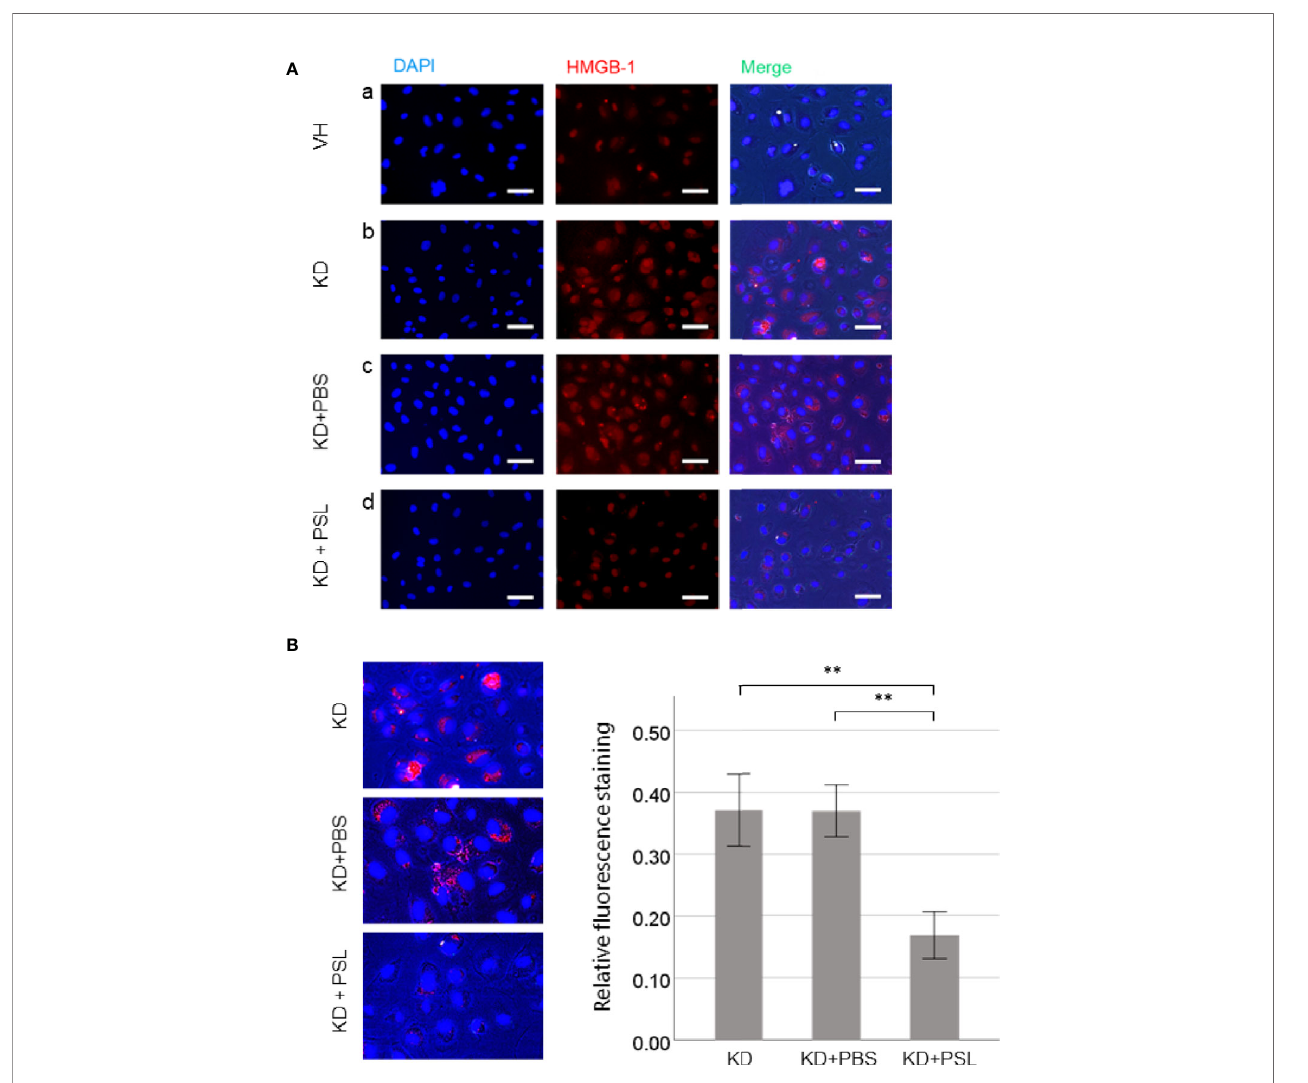
FIGURE 3 | Immunostaining of HMGB-1 in serum-activated human coronary artery endothelial cells (HCAECs) (magni fi cation, ×400). (A) Representative images of from healthy control (VH), Kawasaki disease (KD), and KD serum-activated HCAECs treated with PBS and prednisolone (PSL) showing DNA (blue) labelled using DAPI, HMGB-1 (red) labelled using immuno fl uorescence staining, and merged images. Scale bar = 100 m m. (B) Relative fl uorescence staining of extranuclear HMGB-1 from 100 cells, selected from KD serum-activated HCAECs alone and treated with PBS and PSL. Scale bar = 100 m m. ** P < 0.01 (one-way ANOVA followed by Bonferroni